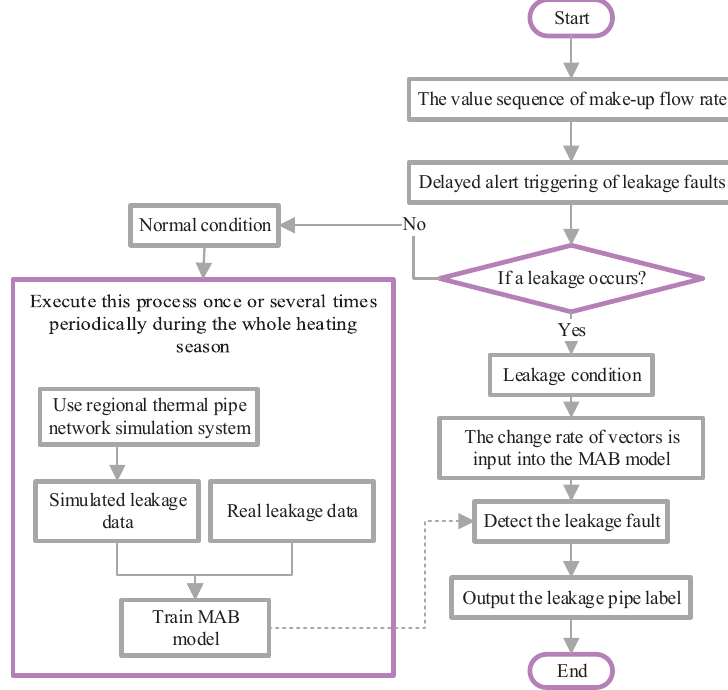
Figure 3. Flowchart of leakage fault detection for Contextual